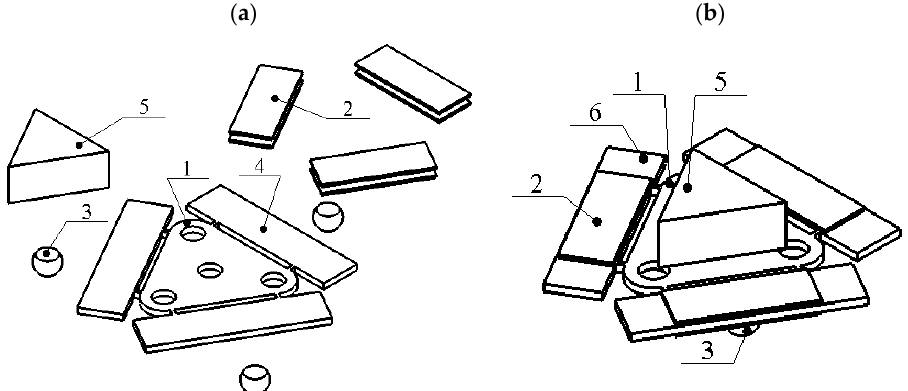
Figure 1. Design of the piezoelectric platform; ( a )—exploited view; ( b )—assembled view; 1—triangle shaped platform; 2—piezo ceramic plate; 3—spherical contact; 4—rectangular plate; 5—payload; 6—piezoelectric bimorph plate.